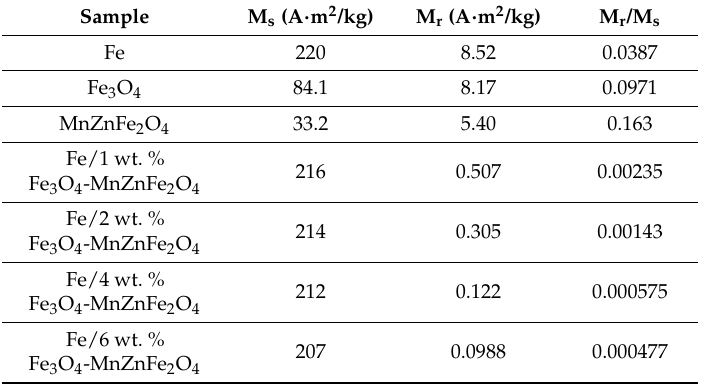
Table 1. Magnetic parameters for Fe, Fe/Fe 3 O 4 -MnZnFe 2 O 4 , Fe 3 O 4 , and MnZnFe 2 O 4 .